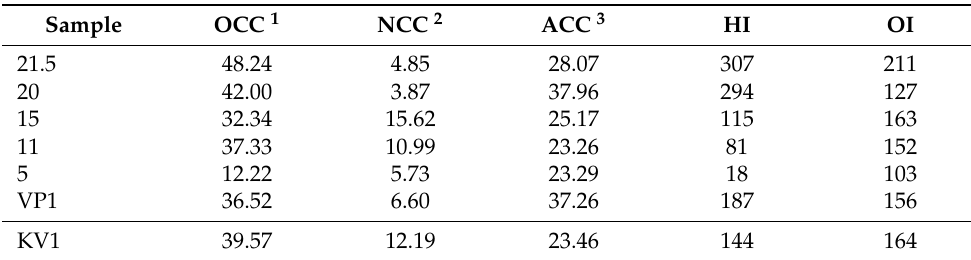
Table 4. The group composition of the Py-GC-MS pyrolysis products and parameters of the Rock-Eval analysis of sediment samples.